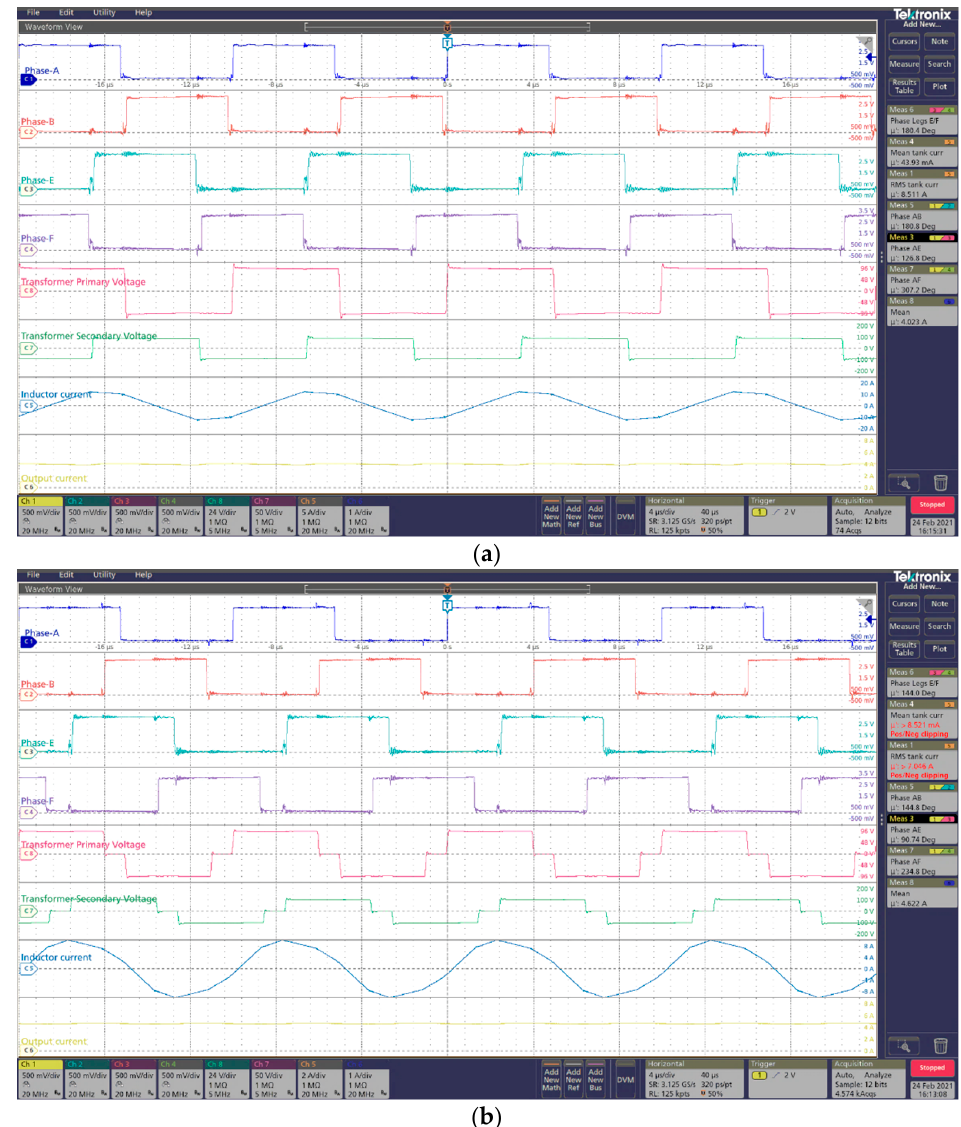
Figure 14. Gate control signals, transformer’s primary and secondary voltage, inductor current and output current average of the experimental model (open loop): ( a ) Case 3; ( b ) Case 5.